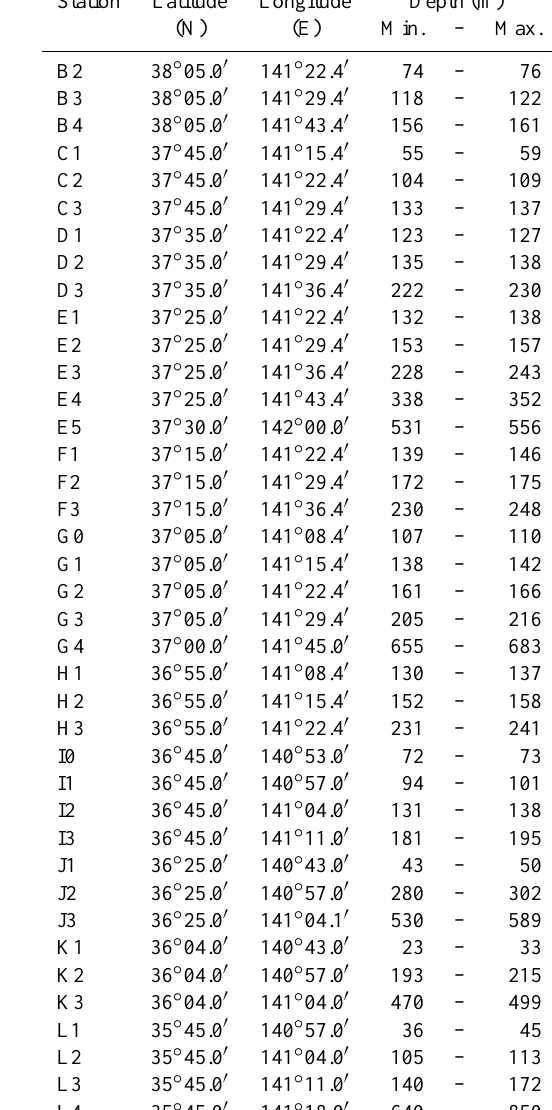
Table 1. Sampling stations during the two phases (sampling date: